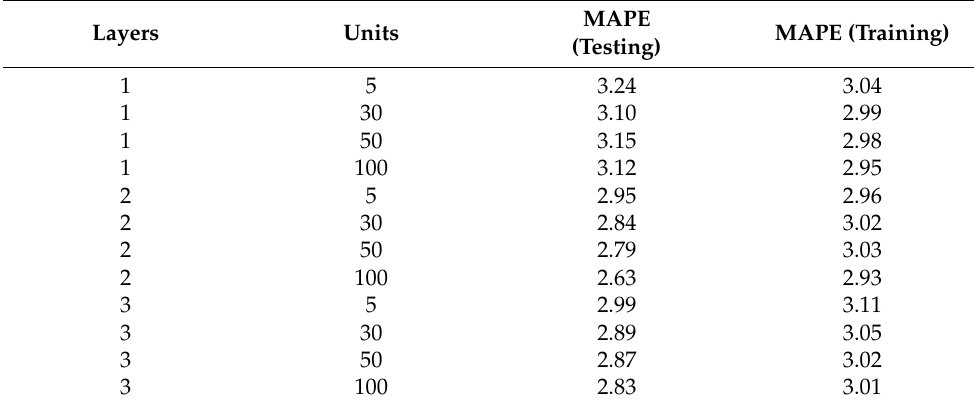
Table 1. MAPE (%) of the proposed model architecture.